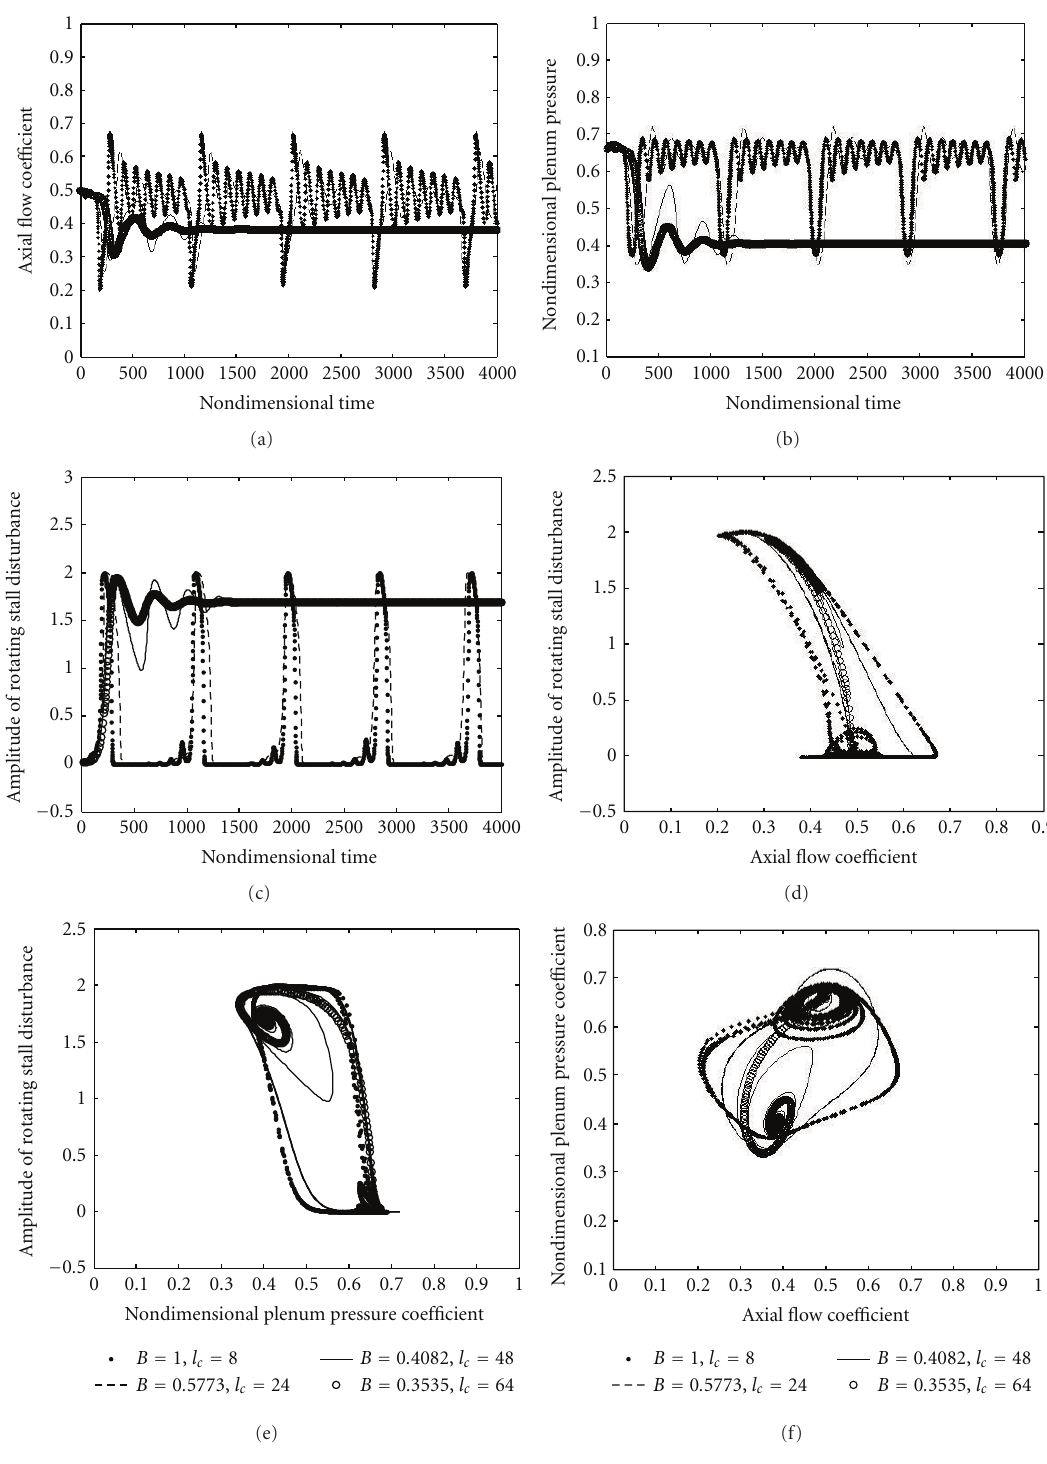
Figure 8: E ff ect of increase in compressor e ff ective length: variation of nondimensional flow properties (a), (b), and (c) with time. (a) Axial flow coe ffi cient, (b) plenum pressure rise coe ffi cient, and (c) disturbance amplitude of rotating stall. (d) Variation of axial flow coe ffi cient with disturbance amplitude of rotating stall. (e) Variation of plenum pressure rise coe ffi cient with disturbance amplitude of rotating stall. (f) Limit cycle oscillation: axial flow coe ffi cient versus plenum pressure rise coe ffi